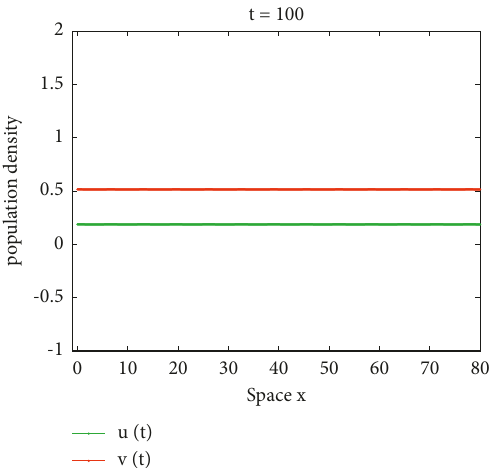
Figure 1: The graph of each node and space x in system (10) when time t � 100 and D